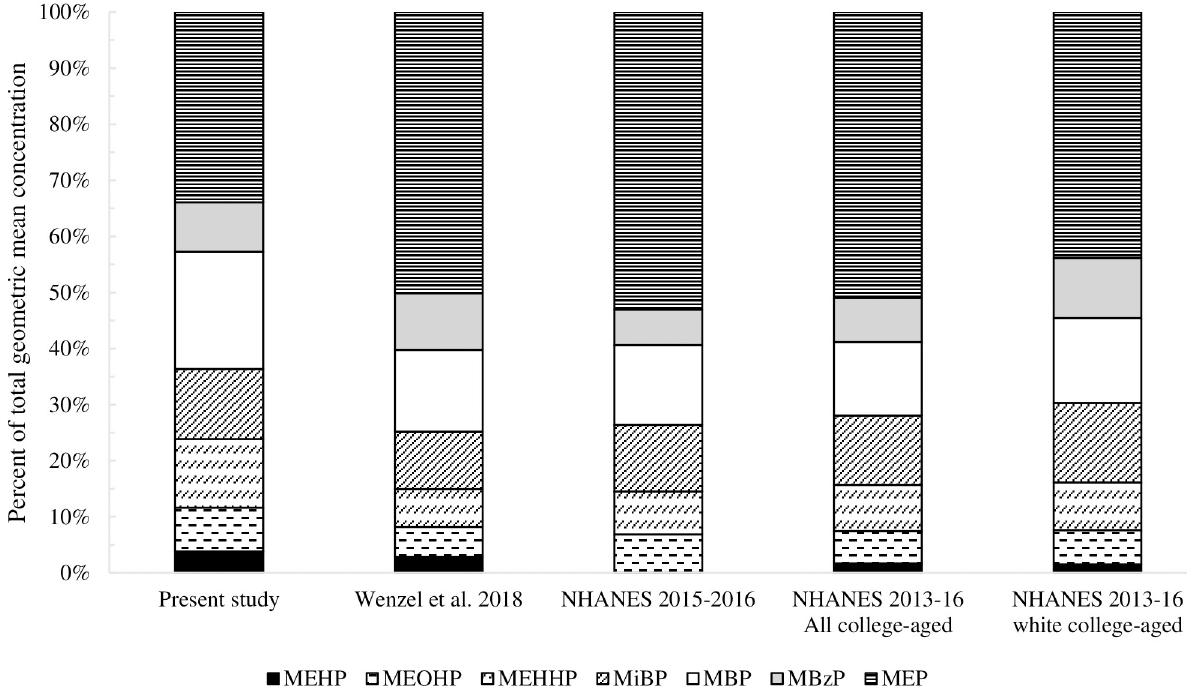
Fig 3. Distribution profile of phthalate metabolites using geometric mean concentrations. Female college students (present study, N = 215) are compared to pregnant adults in another local study by Wenzel et al. [17] (N = 378) and females sampled in NHANES in 2015–2016 (all age 3–80 years, N = 1501) as well as NHANES combined 2013–2014 and 2015–2016 cycles for All college-aged (18–22 years) (N = 184) and non-hispanic white college-aged (N = 56) females.